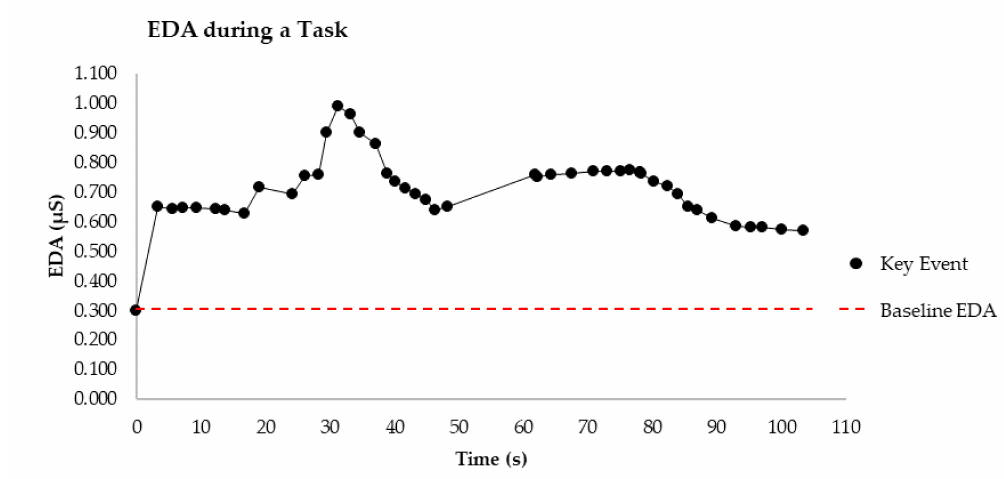
Figure 2. Electrodermal activity (EDA) variation from baseline at key